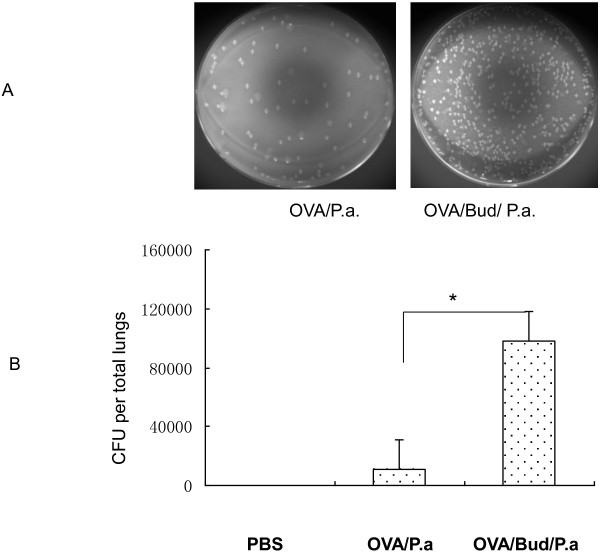
Measurement of CFUs in lung homogenates by quantitative culture of serial dilutions on blood agar plates. Figure 2A represents the bacterial colonies on blood agar plates between OVA/P.a mice and OVA/Bud/P.a mice observed using a Kodak Image 4000MM. Figure 2B represents CFUs, shown in column configuration. There were significantly more CFUs in OVA/Bud/P.a mice than in OVA/P.a mice (*P<0.05). Control mice receiving PBS only had no observable CFUs (0 CFU).